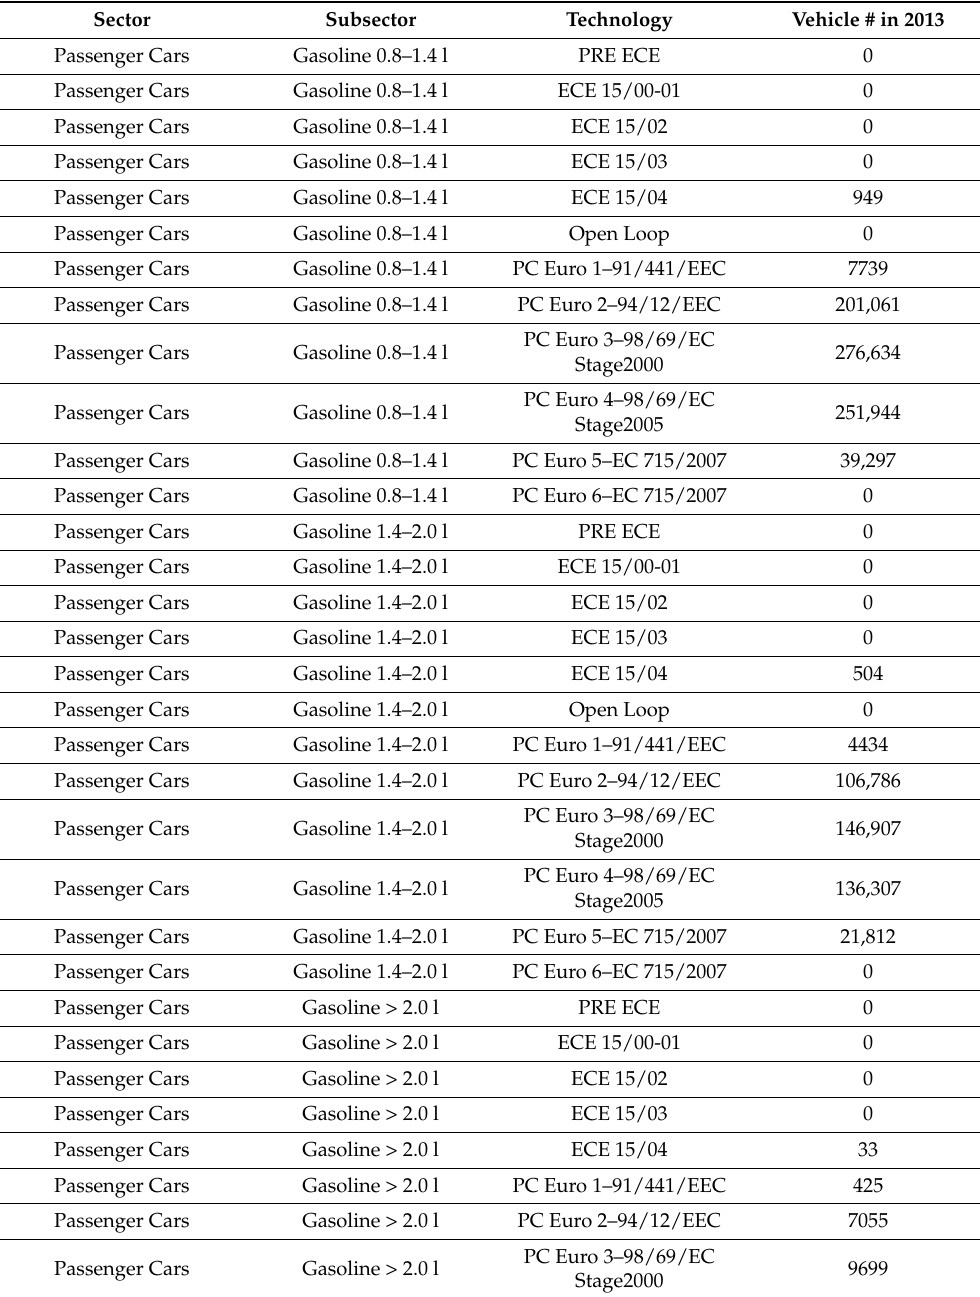
Table A1. Irish fleet data in 2013 (source: Duffy et al.,